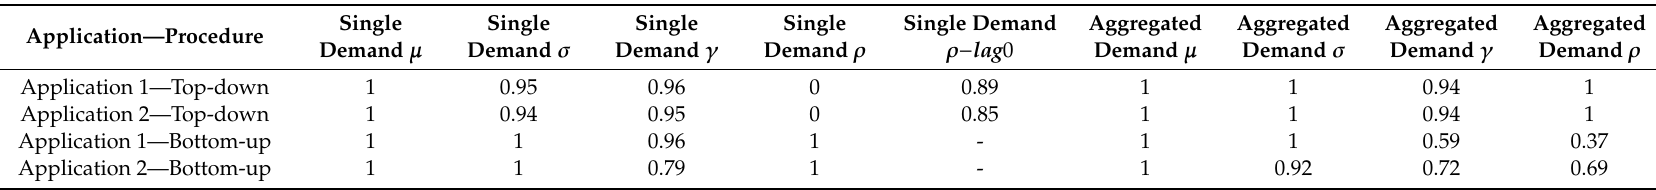
Table 1. Comparison of mean values µ , standard deviation values σ , skewness γ , rank cross-correlations ρ and ρ − lag 0 of measured and generated hourly demands, evaluating the fit in terms of R 2 at both single and aggregated scales, for both applications to the first case study and for both the top-down and the bottom-up